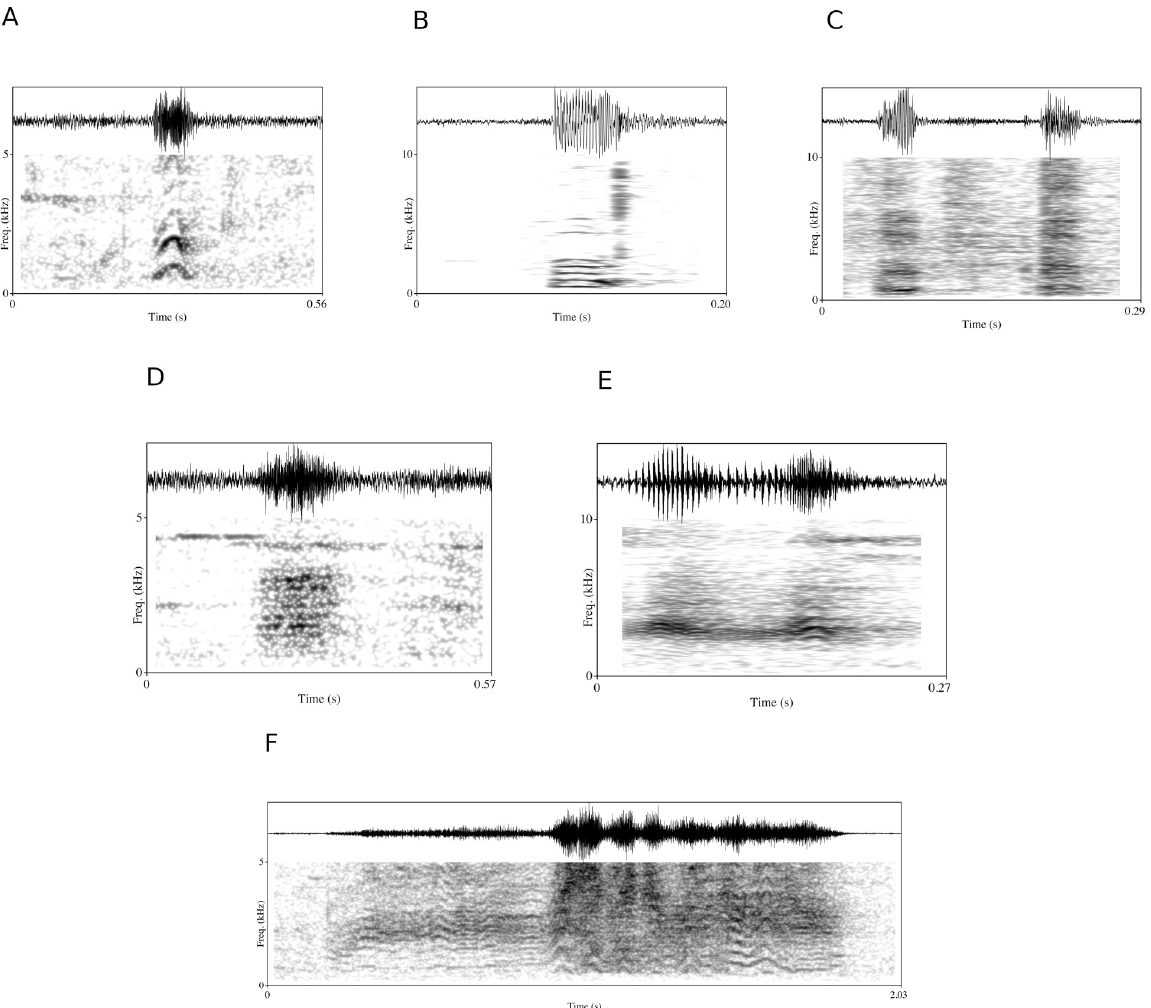
Fig 1. Spectrograms and oscillograms (top) of vocalizations emitted by neotropical river otters. (A) Chirp, (B) squeak, (C) chuckle, (D) hah, (E) growl, (F)